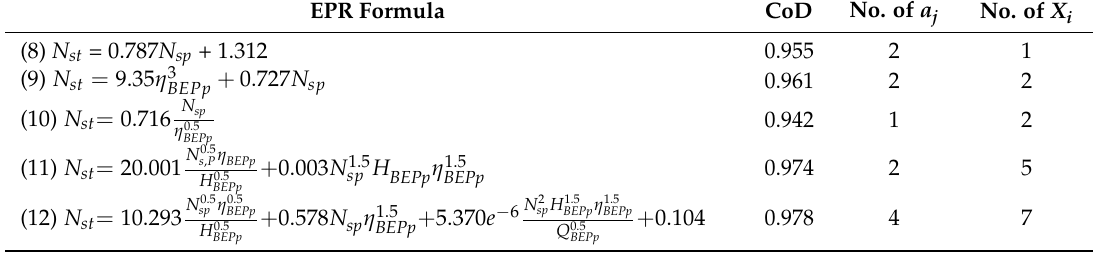
Table 10. Models returned by EPR-MOGA for N st .